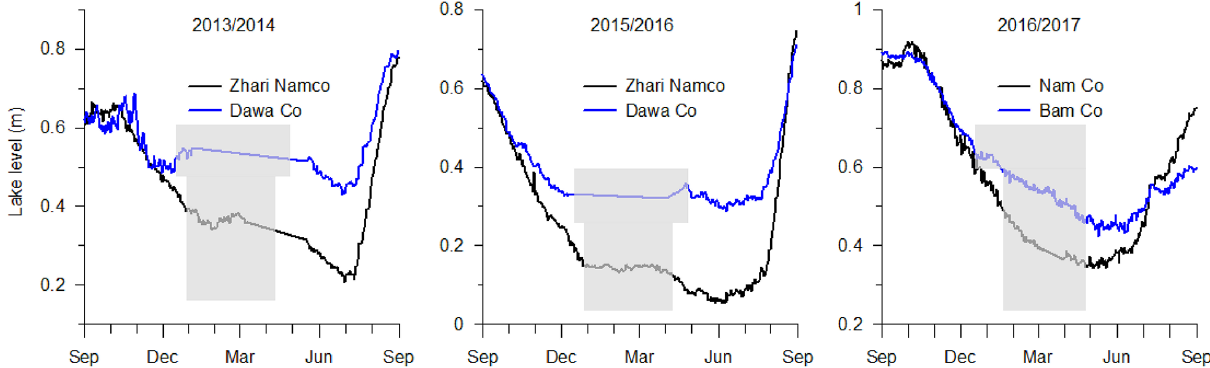
Figure 8. Different amplitude of seasonal lake-level changes between deep and shallow lakes on the central TP. Relatively deep lakes: Zhari Namco (85.61 ◦ E, 30.93 ◦ N) and Nam Co (90.60 ◦ E, 30.74 ◦ N). Relatively shallow lakes: Dawa Co (84.96 ◦ E, 31.24 ◦ N) and Bam Co (90.58 ◦ E, 31.26 ◦ N). Grey rectangles in each figure represent lake ice-covered